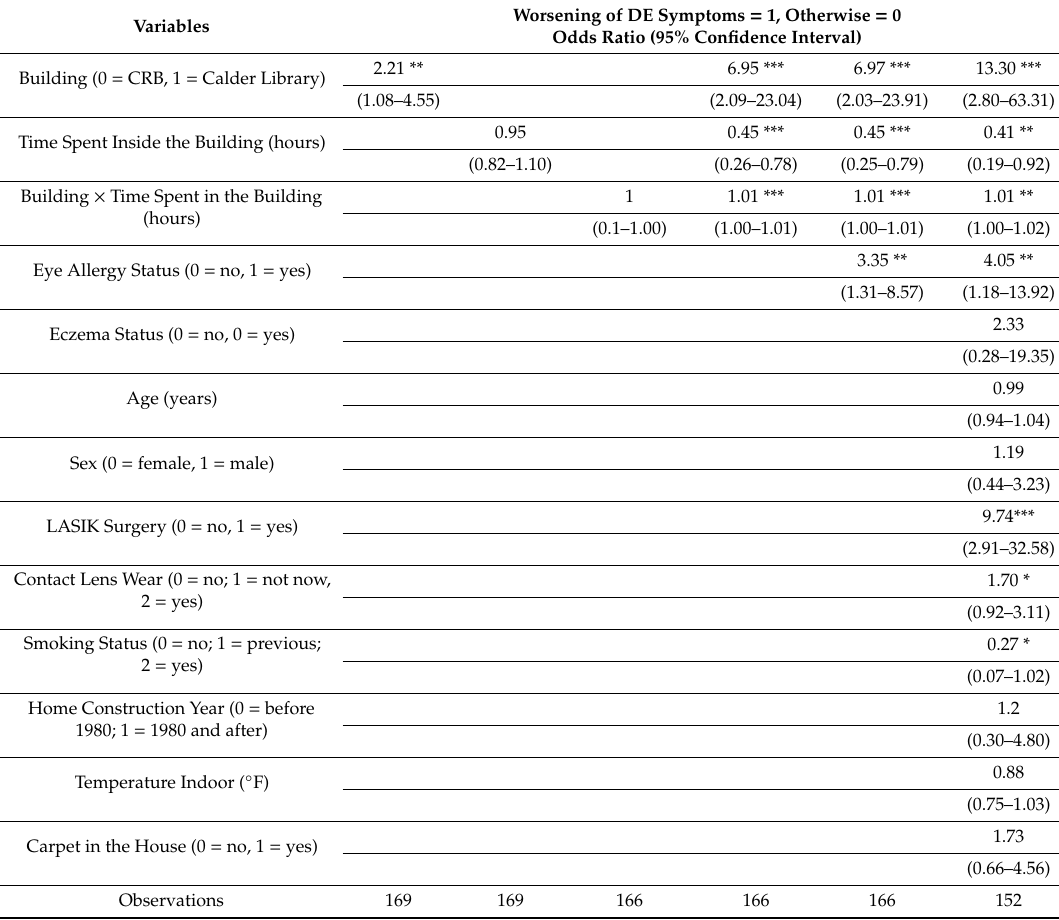
Table 5. Multivariable analysis of factors associated with worsening DE symptoms after spending time in the selected